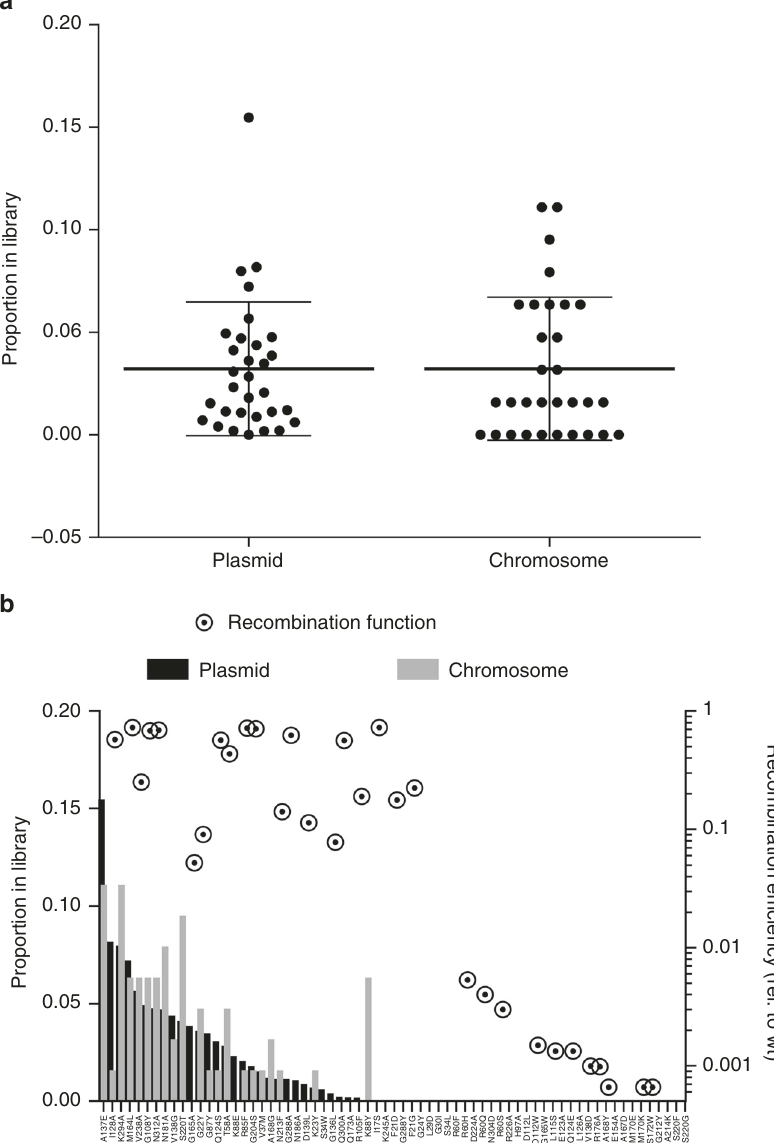
Fig. 5 The distribution of recA alleles encoded by the plasmid pool before CRISPR-FRT is similar to the distribution of recA mutants transferred to the chromosome after CRISPR-FRT. a Column scatter graph showing the distribution of recA mutants encoded by the plasmid pool before CRISPR-FRT and recA mutants on the chromosome after CRISPR-FRT. Mean proportion of mutants shown with heavy bars and standard deviation shown with light bars ( n = 31). b Distribution of individual recA mutants before and after CRISPR-FRT. Plotting previously reported 12 relative recombination function of recA mutants (circles, second y-axis) suggests deleterious mutants with <1% recombination activity are underrepresented in the original plasmid library